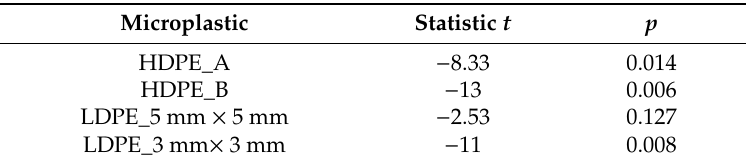
Figure 7. ( a ) Mass loss after photolysis at pH 3. Mass loss after photocatalysis of ( b ) high-density polyethylene (HDPE) and ( c ) low-density polyethylene (LDPE) microplastics at pH 3 using N–TiO 2 coating. Both experiments were conducted using visible irradiation for 50 h. Table 1. Statistical analysis of differences between means of mass loss between photolysis and photocatalysis with N–TiO 2 at 50 h of irradiation.